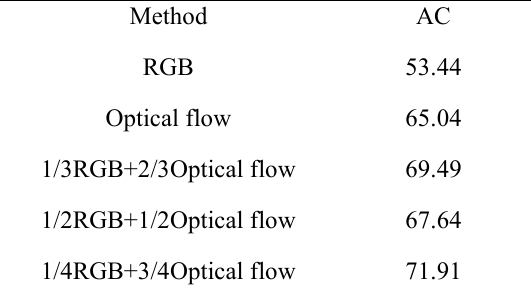
Figure 6. Comparison of recognition accuracy with different video segment number